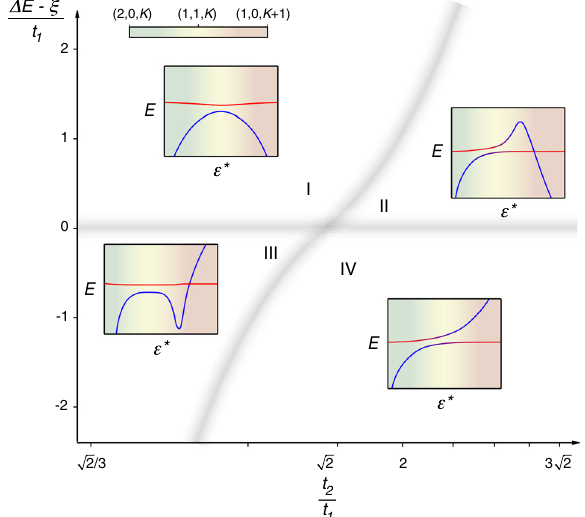
FIG. 12. Illustration of qualitatively different exchange profiles arising from the interplay between the level spacing in the multielectron quantum dot Δ E , spin correlation energy ξ , and tunnel couplings between a single-electron dot and two lowest orbitals of the multielectron quantum dot t 1 . Colored lines in the = 2 insets I – IV represent the energies of the three-spin states with ¼ − 1 = 2 as a function of detuning ε (cid:2) S ¼ 1 = 2 , S z